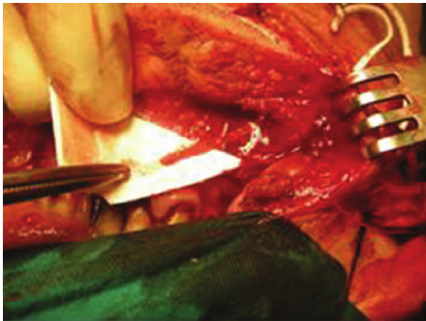
Figure 4: Harvesting of the free composite dorsalis pedis-extensor hallucis brevis